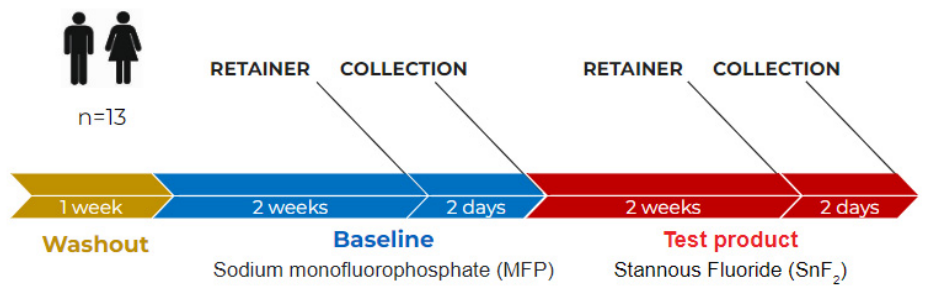
Figure 2. Schematic of the clinical study design.